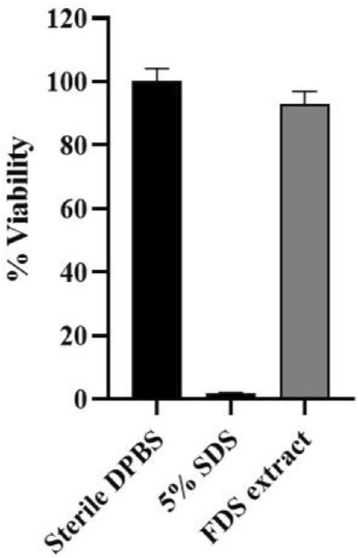
Figure 7. %Viability of the 3D skin model (EpiDerm) was measured after treating with sterile Dulbecco’s phosphate-buffered saline (DPBS) as a negative control, 5% sodium dodecyl sulfate (SDS) as a positive control, and the F. dubia sap (FDS) extract at 830 mg/mL. The experiments were conducted in